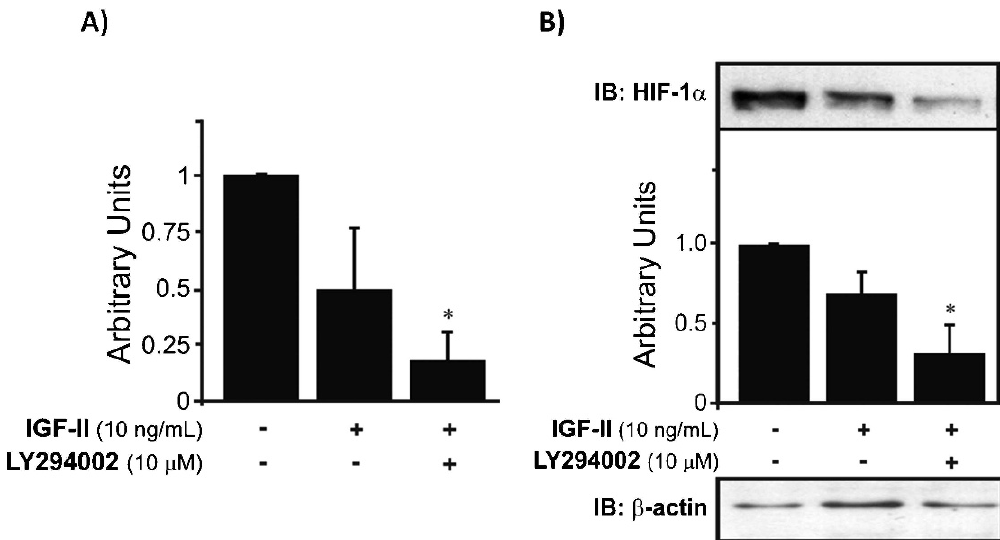
Figure 3 - HIF-1 a mRNA expression and protein levels in human chondrocytes treated with IGF-II. A) Unlike IGF-I, when IGF-II treatment was applied, the mRNA expression of HIF-1 a was decreased, and this downregulation was enhanced (* p , 0.05) when IGF-II and LY294002 were applied together. Inhibition of PI-3K by LY294002 caused downregulation of HIF-1 a mRNA to reduced levels compared to those of the controls. B) However, HIF-1 a protein expression was also decreased by IGF-II treatment. This growth factor is regulated by the PI-3K pathway, as well, because inhibition of this pathway by LY294002 decreased the expression of HIF-1 a (* p , 0.05). The results were normalized to endogenous b